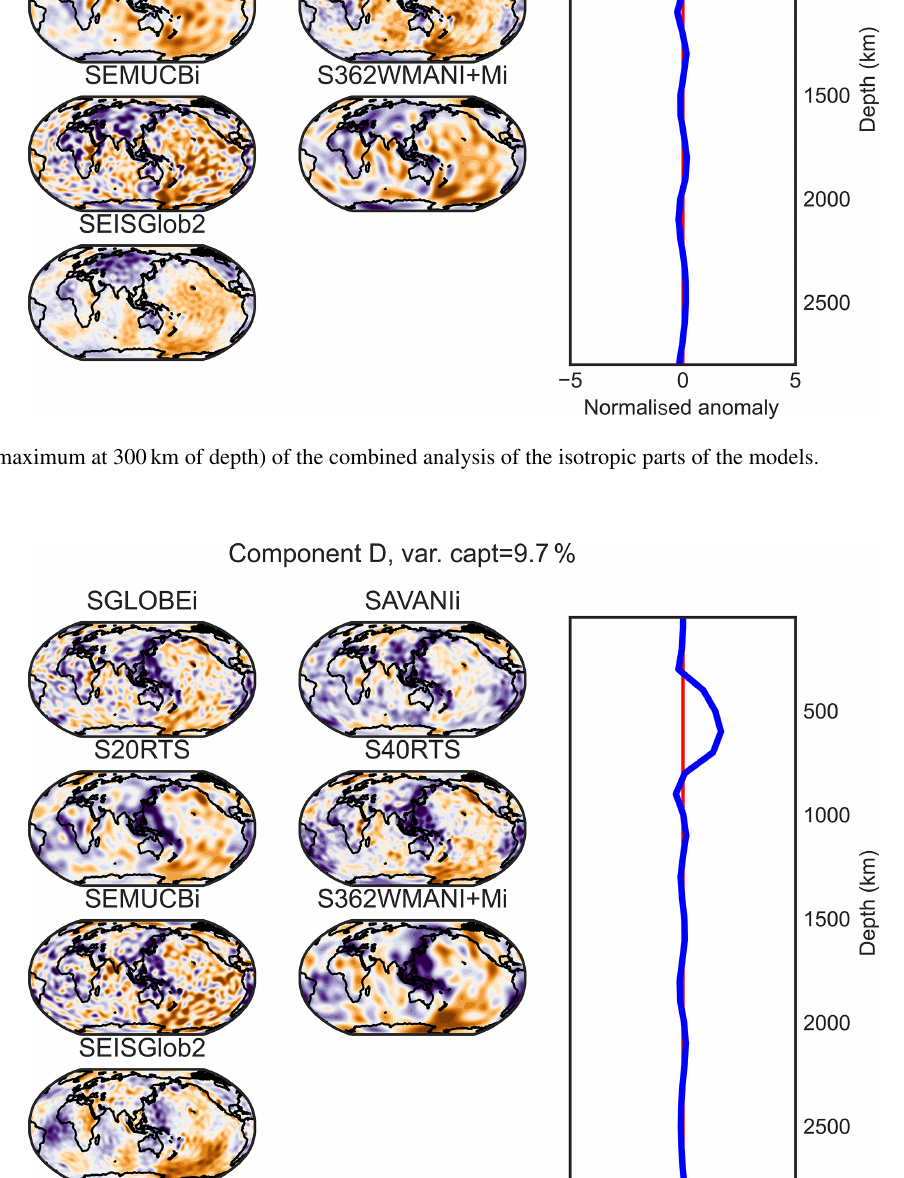
Solid Earth, 12, 1601–1634,